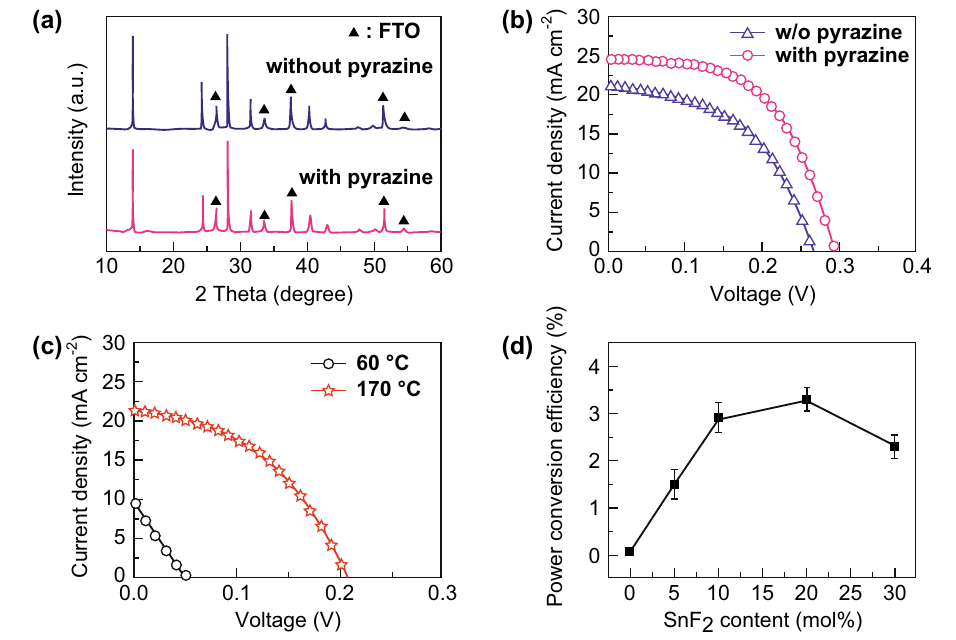
Fig. 23 XRD patterns of FASnI 3 films a with and without pyrazine deposited on FTO glass, b with and without the presence of SnF 2 (10 mol%), c in the absence of SnF 2 annealed at 60 and 170 (cid:3) C, and d PCE of the FASnI 3 and the amount of SnF 2 added in the absence of pyrazine. Reproduced with permission Ref. [32]. Copyright (cid:2) 2016 American Chemical Society